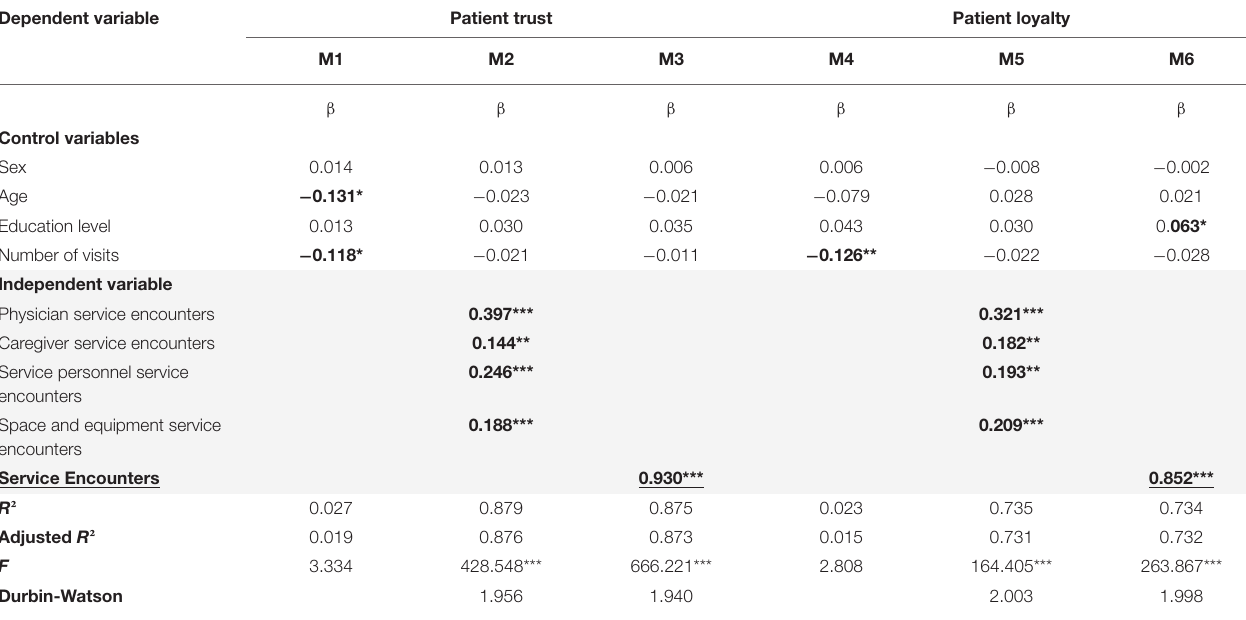
TABLE 9 | Regression analysis of post-service encounter satisfaction with patient trust and loyalty ( n = 483). Dependent